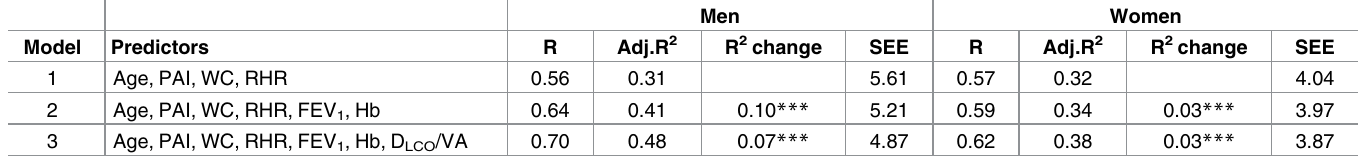
Table 2. Summaryof multiple linear regressions models predicting VO 2peak.